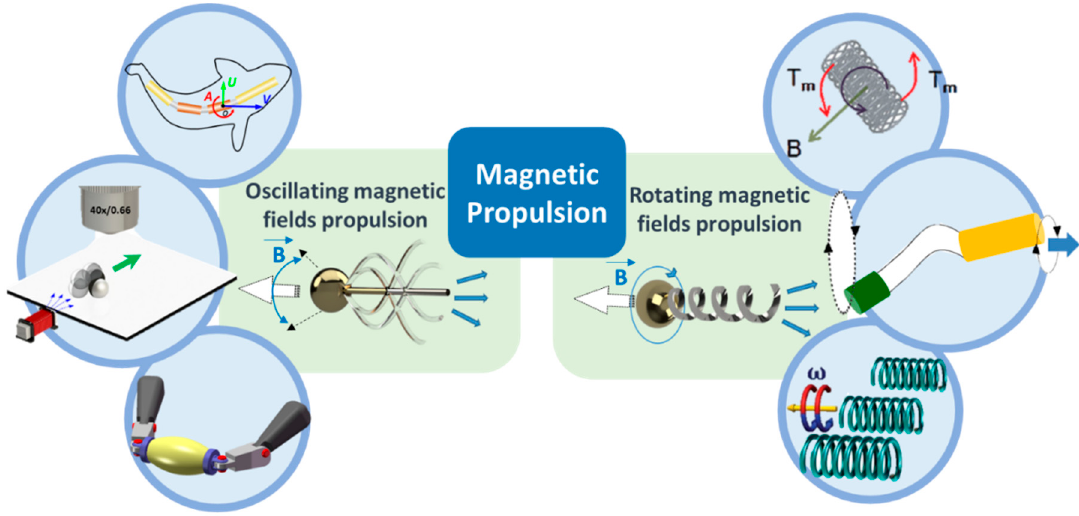
Figure 1. The categories of magnetic propulsion. Adapted with permission from Reference [84], copyright Small 2016; adapted with permission from Reference [85], copyright Advanced Functional Materials 2018; adapted with permission from Reference [83], copyright Nano Letter 2017; adapted with permission from Reference [100], copyright Advanced Materials 2013; adapted with permission from Reference [101], copyright Journal of the American Chemical Society 2010; adapted with permission from Reference [102], copyright Nanoscale 2014.